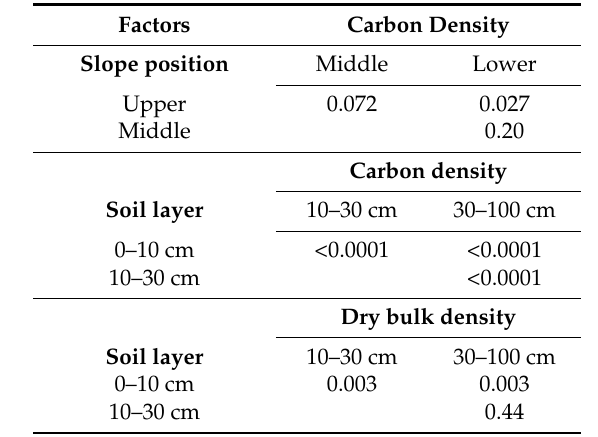
Table A1. The p values of the multiple comparisons of factors, slope positions and soil layers, for soil carbon density and dry bulk density by the Shaffer’s modified sequentially rejective Bonferroni procedure.